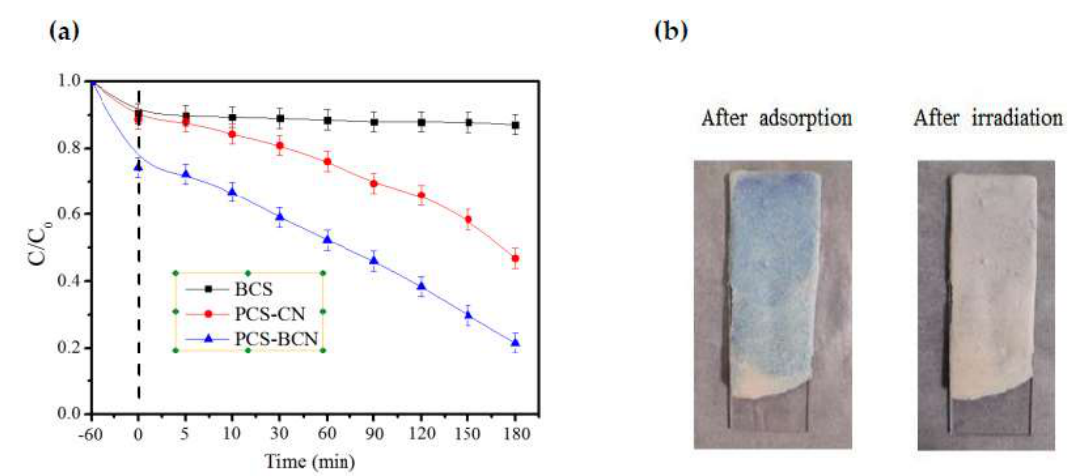
Figure 15. Photocatalytic of MB removal efficiency of BCS, PCS-CN and PCS-BCN under dark adsorption and light-driven photocatalytic ( a ) and color changes following irradiation of MB on the PCS-BCN surface ( b ).